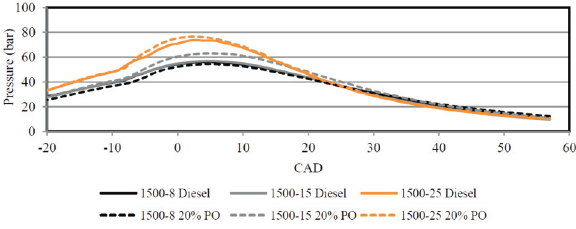
Fig. 2. In cylinder pressure results for diesel and pyrolysis fuel